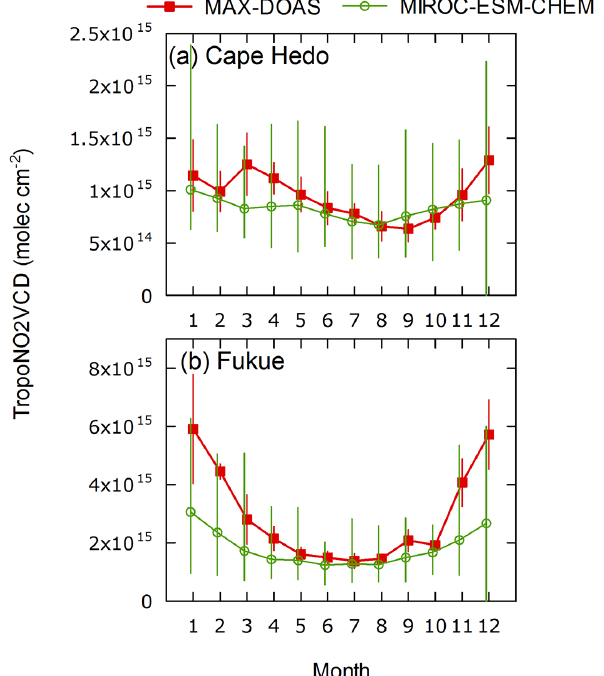
Figure 17. Comparisons of average seasonal variations in Tro- poNO2VCD derived from MAX-DOAS observations and model simulations (MIROC-ESM-CHEM). Data from the hours of satel- lite observations (OMI) are used. Error bars for MAX-DOAS rep- resent variations in the monthly averages over the studied years, whereas those for model simulations represent the full ranges of hourly averages included in each hour.